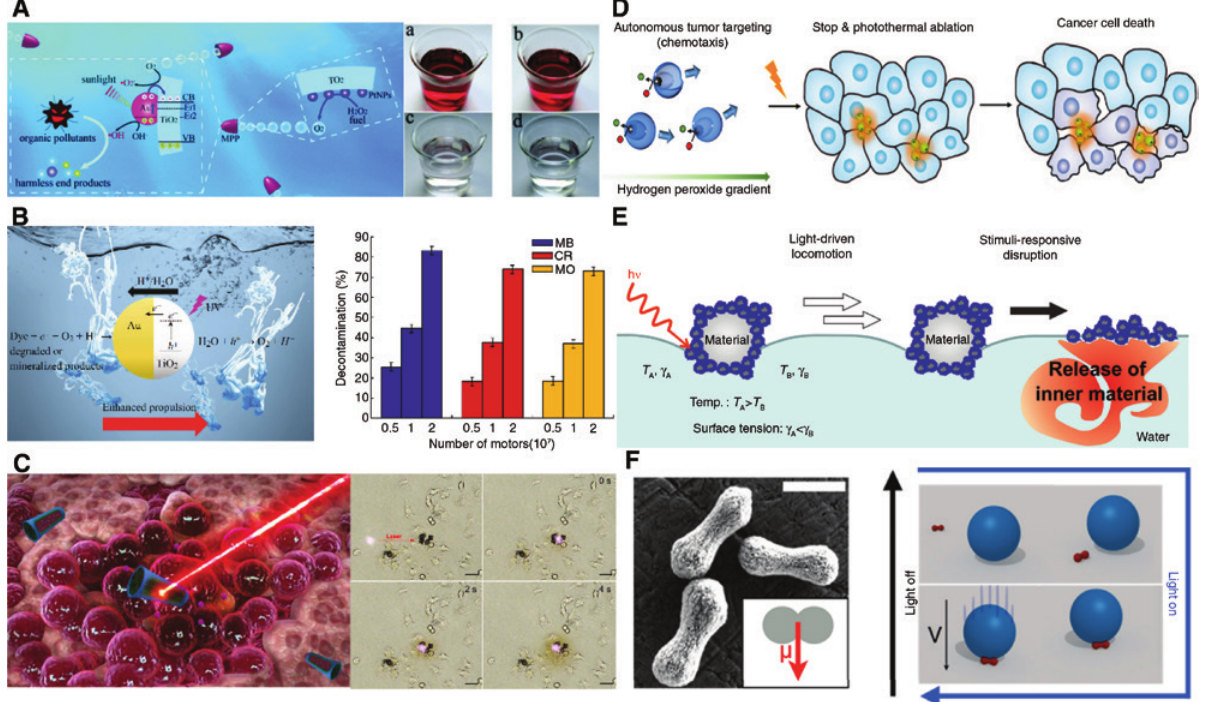
Figure 1: Applications of light-driven micro/nanomotors in environment remediation, biomedical field and cargo delivery. (A) Micromotors with plasmonic photocatalyst are fabricated to degrade organic pollutants rhodamine B and methyl orange [38]. Copyright 2016, The Royal Society of Chemistry. (B) Light-driven TiO /Au micromotors and enhanced motion in dye samples. The percent decontamination of 2 methylene blue (MB), cresol red (CR) and methyl orange (MO) with an increased number of motors are shown [37]. Copyright 2017, Springer. (C) A bovine serum albumin/poly-l-lysine (PLL/BSA) micromotor, which is fabricated with biodegradable protein, was successfully applied into cancer drug encapsulation, delivery and release, which is controlled by NIR light [39]. Copyright 2014, American Chemical